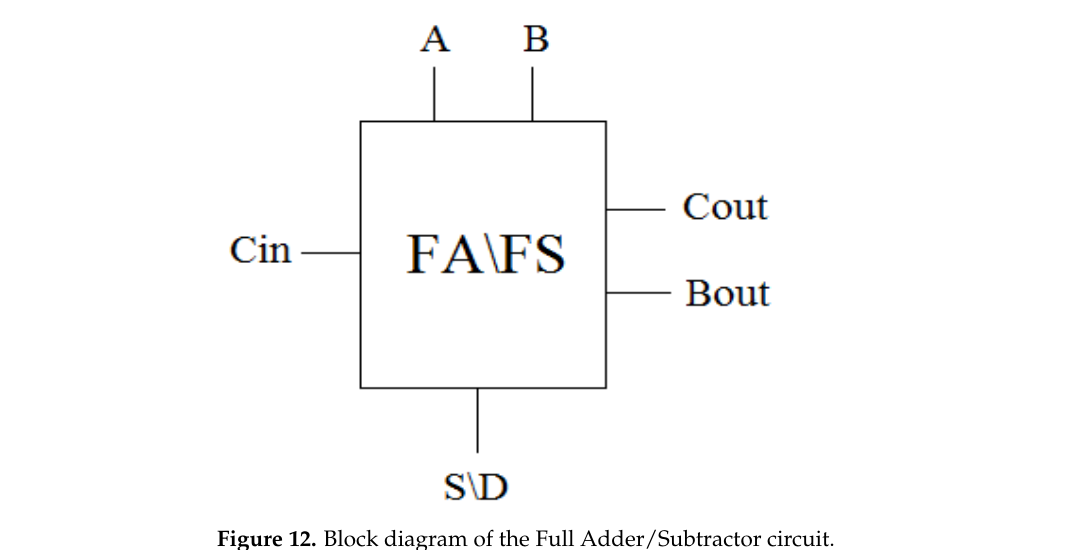
Figure 12. Block diagram of the Full Adder/Subtractor circuit. Table 1. Truth table of the Full Adder/Subtractor.